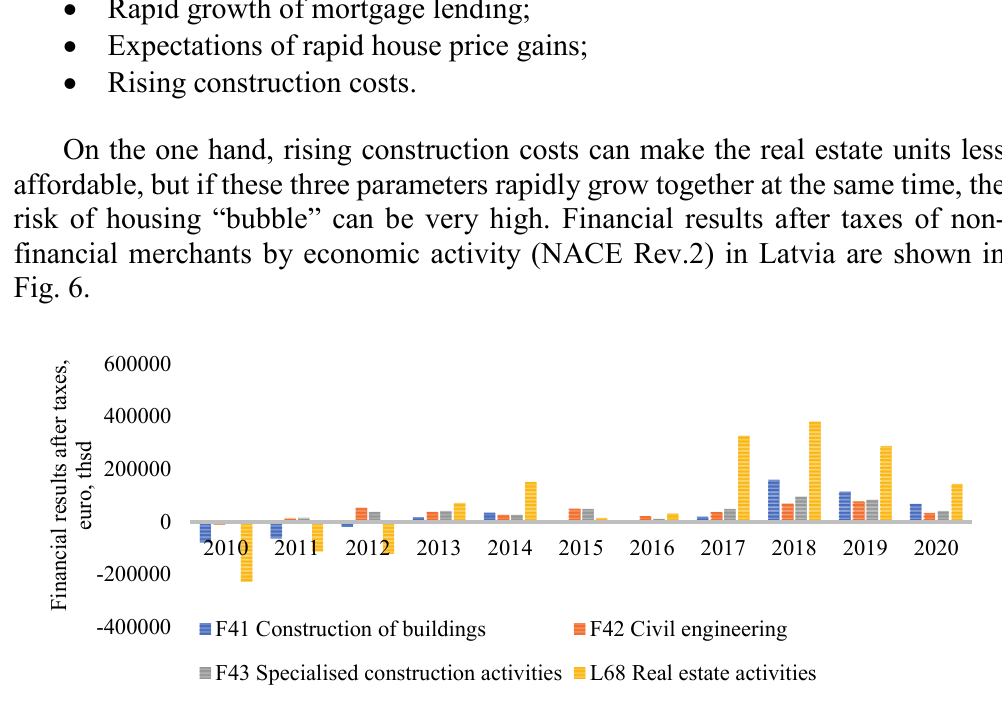
Fig. 6. Financial results after taxes of non-financial merchants by economic activity (NACE Rev.2) from 2010 to 2020 (profit or losses, euro, thsd) (developed by the authors based on European Statistics Database